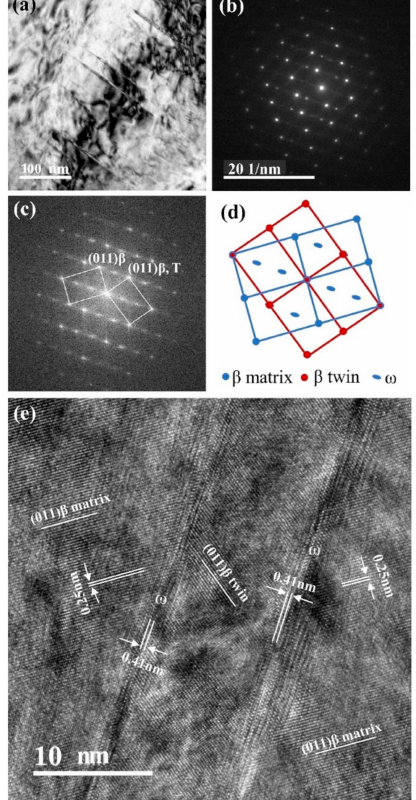
Figure 4. Microstructure of EP0.58 after tensile tests at 200 K: ( a ) Bright field image displaying several twin lamellae, ( b ) (110) β zone axis SAED patterns, ( c ) FFT patterns corresponding to the HRTEM image ( e ). ( d ) Key diagram corresponding to ( b ). ( e ) the HRTEM image of the twin lamellae in ( a